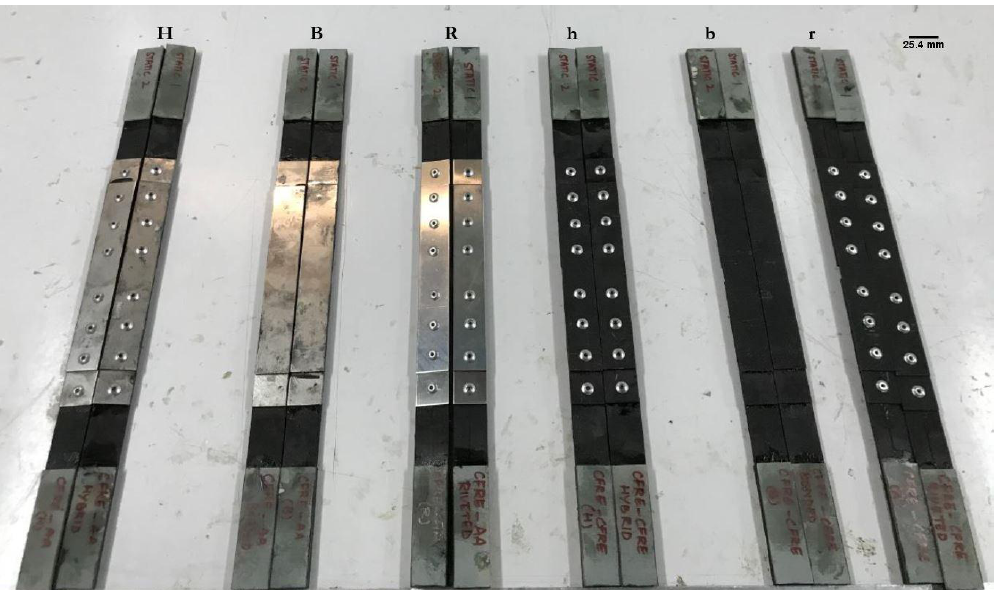
Figure 2. From left to right, hybrid ( H ), adhesive bonded ( B ), and riveted ( R ) joints of composite substrate with metal doublers, and hybrid ( h ), adhesive bonded ( b ), and riveted ( r ) joints of composite substrate with composite doublers.